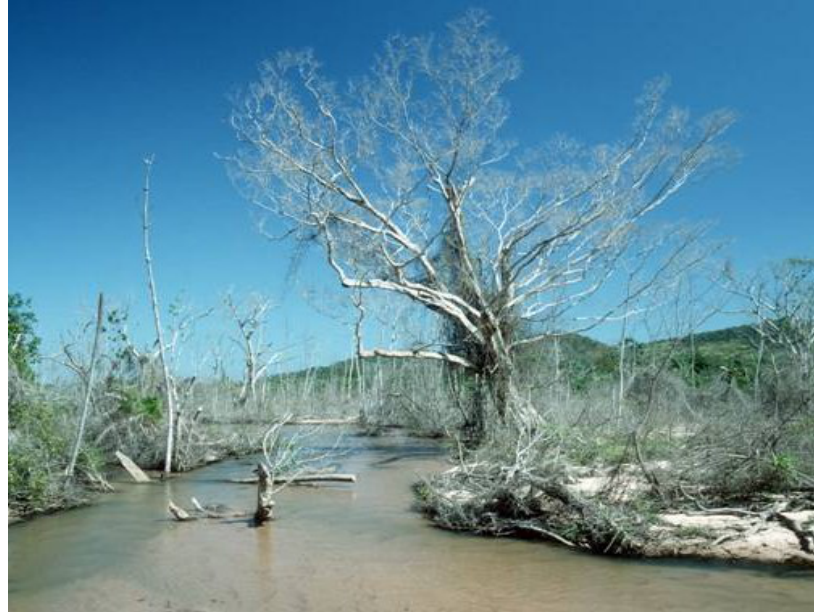
Figure 6. Die-back of riparian vegetation and stream braiding due to excessive sediment deposition originating from agricultural erosion. See Wantzen [66] for